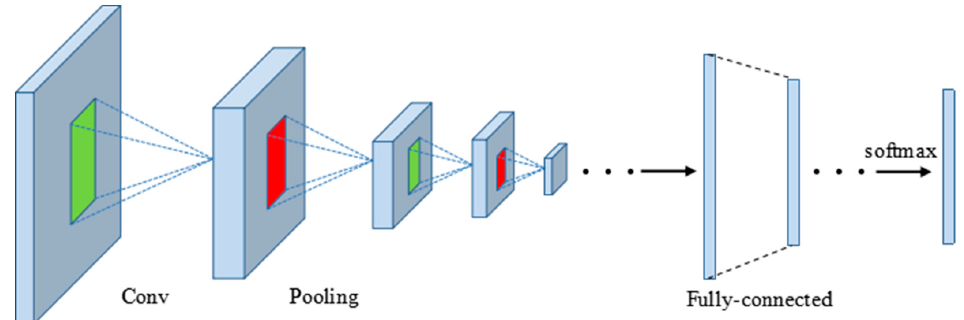
Figure 5. The convolutional neural network (CNN) architecture.